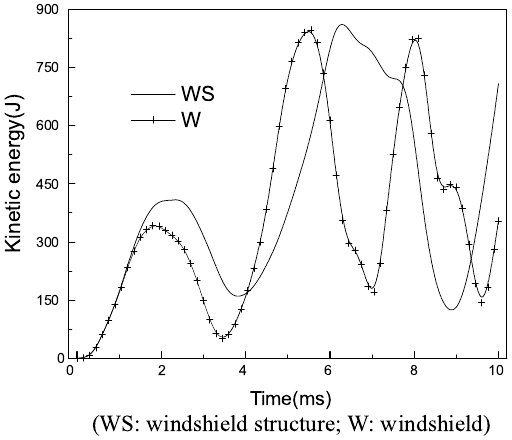
Fig. 22. Time history of kinetic energy of windshield.